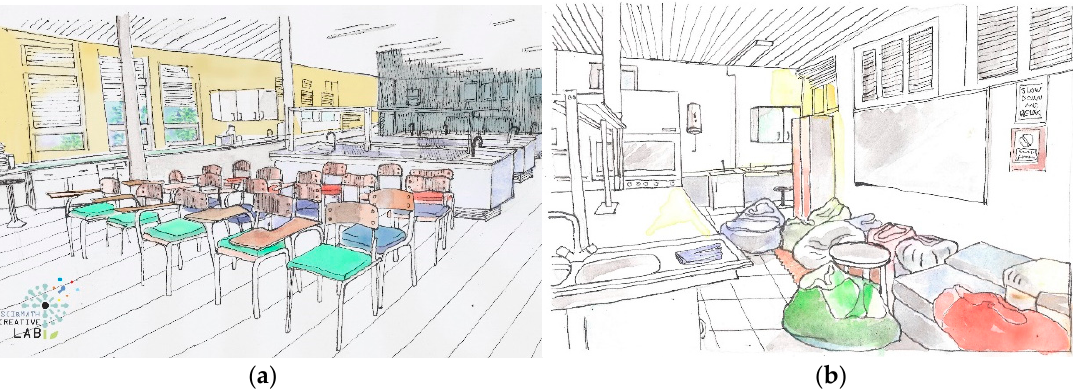
Figure 2. CreativeLab_Sci&Math space (art by Clara Brito). Area with the chairs ( a ) is related to the Engage, Explain and Exchange moments. Behind it, students can work in three areas in large groups and do laboratorial activities or explore digital resources (Explore, Exchange, Evaluate). In the left side, there is an area where students can also work alone or in small groups. At the end of the classroom ( b ), there is a working space with lounge characteristics that can be used by students in Engage, Exchange or Explore